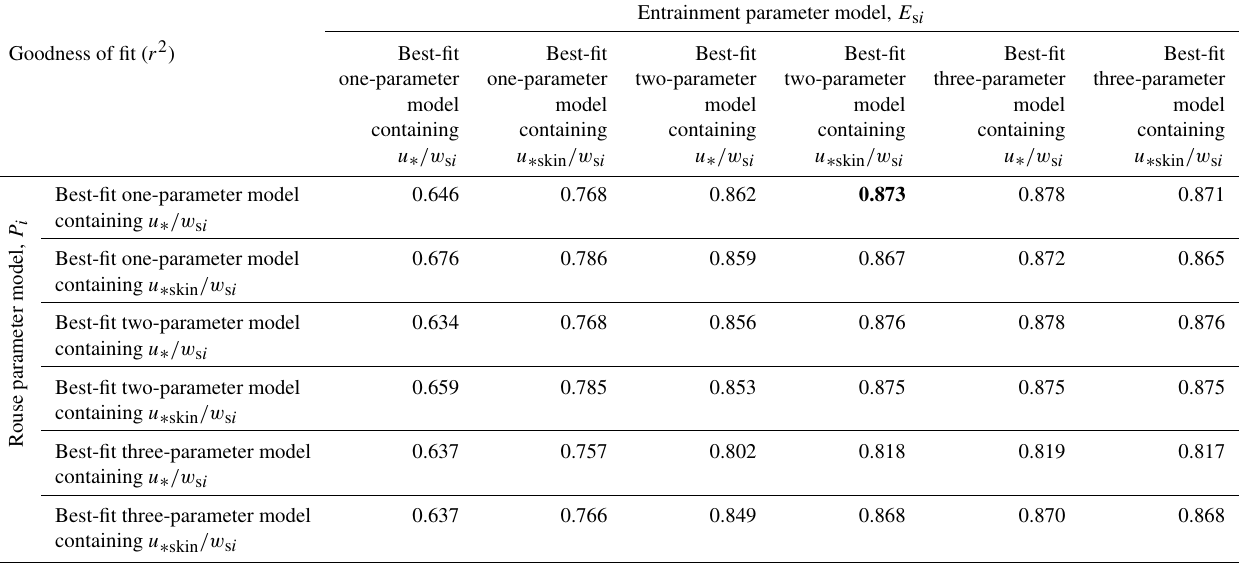
Table 6. Coefficient of determination ( r 2 ) of grain-size-specific sediment concentration at each sample elevation in the water column for different combinations of models for the entrainment, E s i , and Rouse, P i , parameters. The favored model combination is highlighted in bold font.